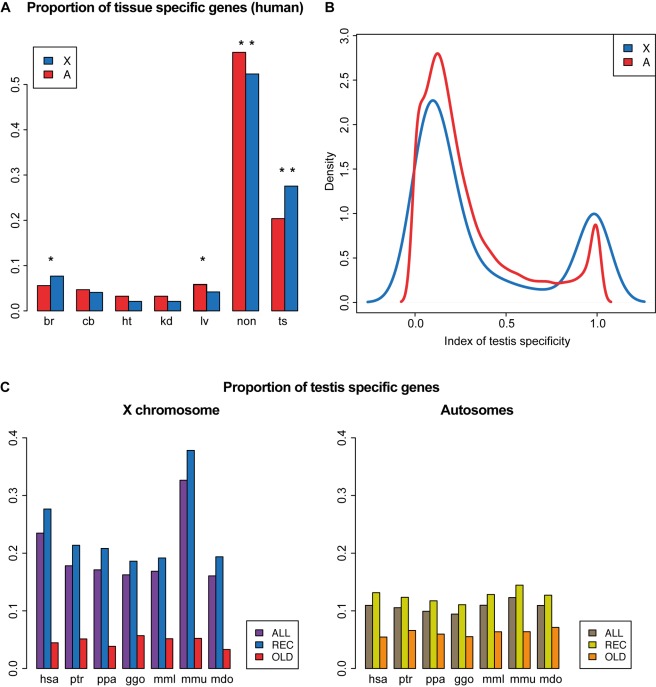
Distributions of tissue-specific genes in the human genome and testis-specific genes therian genomes.(A) Proportions of tissue-specific genes on the human X chromosome and autosomes, respectively: br, brain; cb, cerebellum; ht, heart; kd, kidney; lv, liver; non, no tissue-specificity; and ts, testis. Statistically significant differences as assessed by Fisher exact test are indicated: *two-tailed p<0.05; *two-tailed p<0.01. (B) Density plots of testis-specificity index for genes on the human X chromosome and autosomes. (C) Proportions of testis-specific genes on therian X chromosomes and autosomes, for all expressed genes (ALL), “recent” genes ([REC], i.e., all genes except 1∶1 orthologs present on both the current chromosomes and ancestral/proto chromosomes), and “old” genes ([OLD], i.e., 1∶1 orthologs present on both the current chromosomes and ancestral/proto chromosomes). Species: hsa, human (Homo sapiens); ptr, chimpanzee (Pan troglodytes); ppa, bonobo (Pan paniscus); ggo, gorilla (Gorilla gorilla); mml, macaque (Macaca mulatta); mmu, mouse (Mus musculus); mdo, opossum (M. domestica).